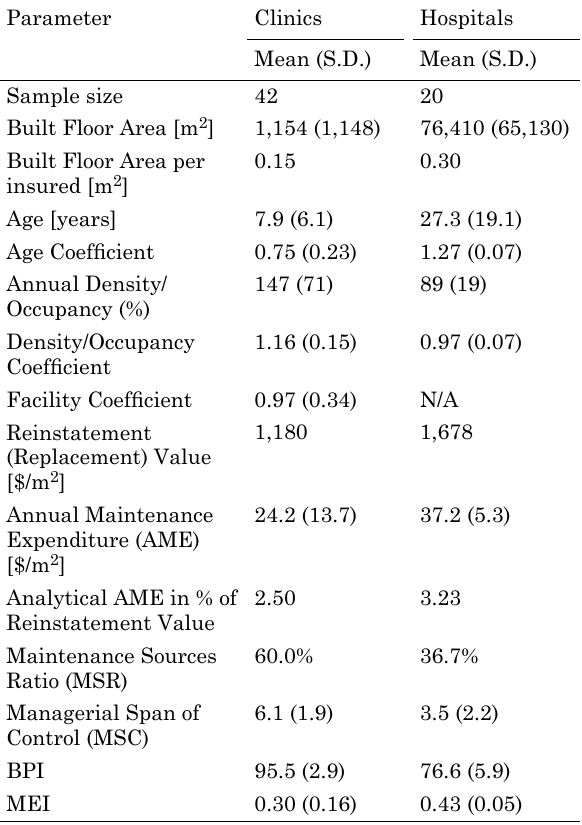
Table 1. Comparative profile of hospital and